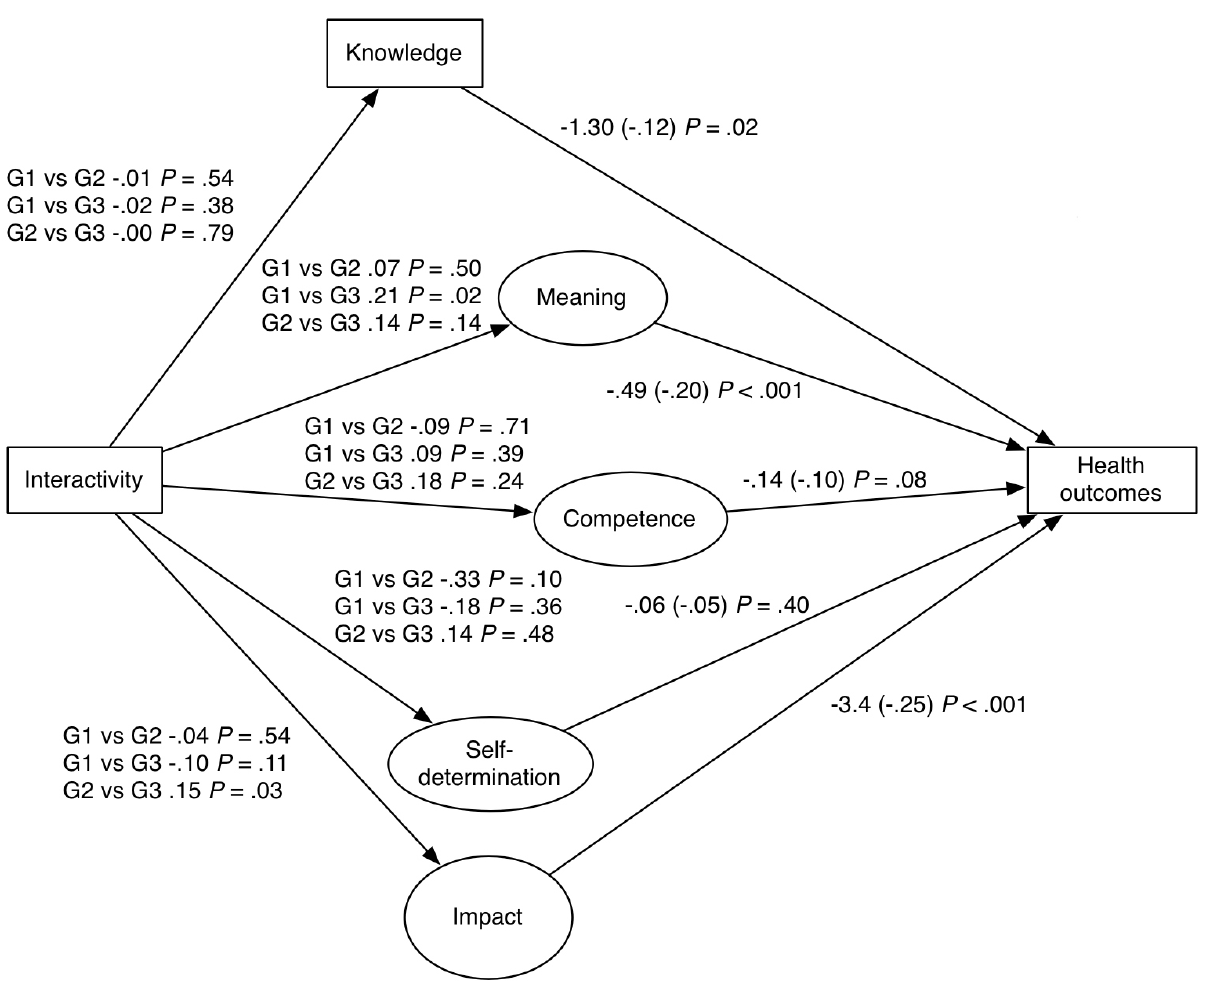
Figure 3. Overall model results. G1 = static-only study group; G2 = interactive-only study group; G3 = full application study group. Standardized coefficients are in parentheses (see Multimedia Appendix 2-7 for